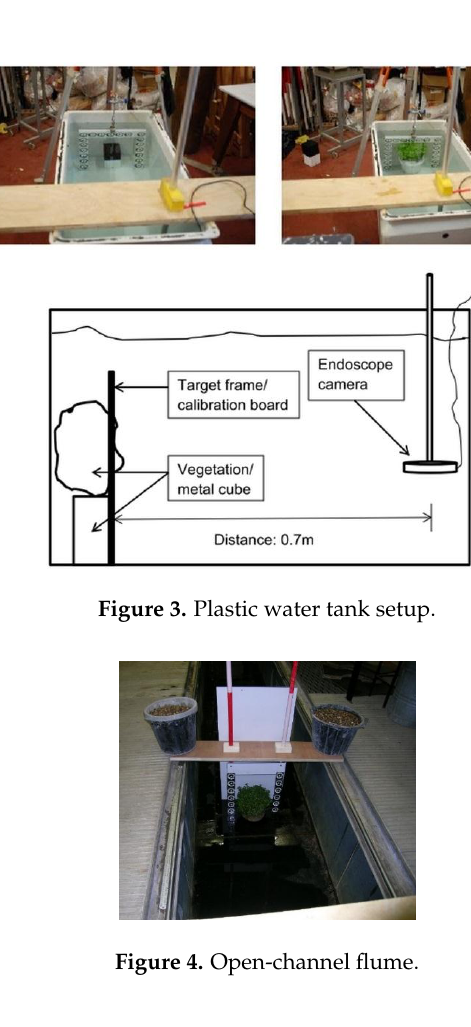
Figure 2. Underwater endoscope camera (resolution: 640 × 480 pixels; price July 2013: £25).